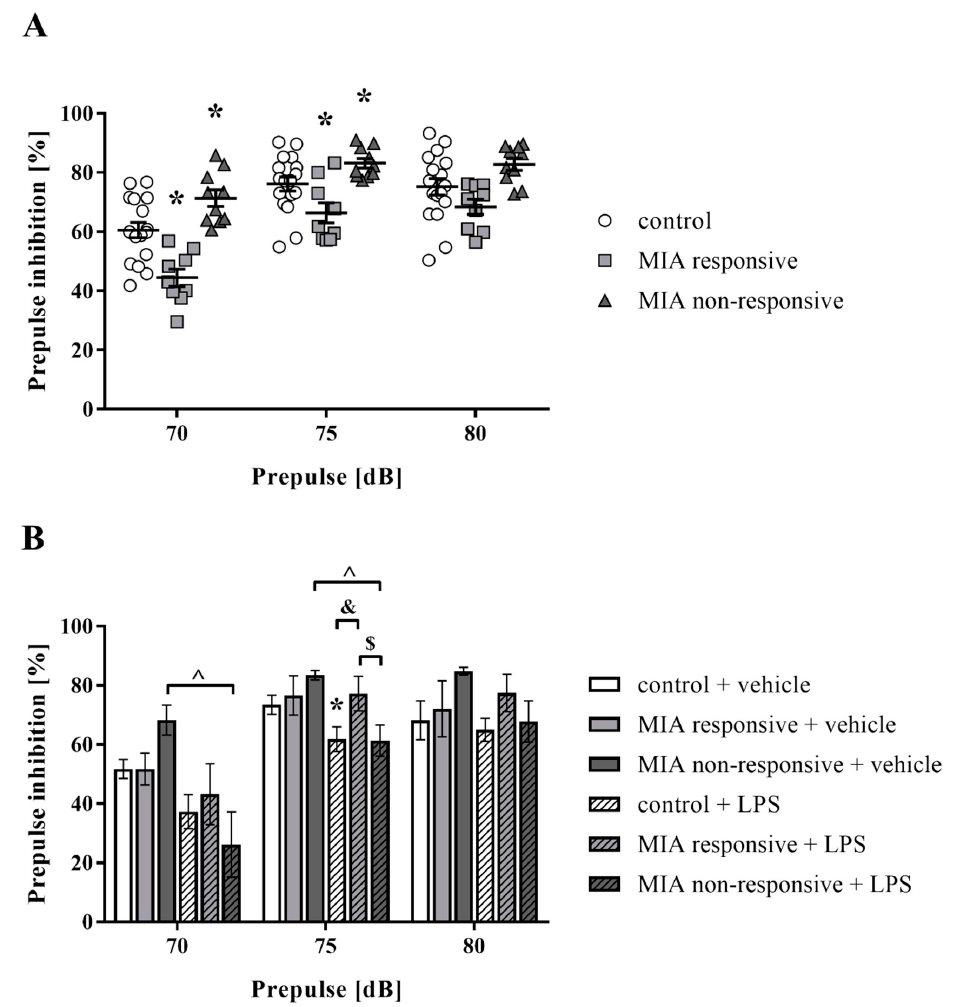
Figure 5. ( A ) The PPI test at PND100 revealed two distinct behavioural phenotypes: MIA responsive (with the deficit in PPI) and MIA non-responsive (without the deficit) in male Sprague-Dawley offspring exposed to MIA. n = 17 in the control group, n = 9 in the MIA responsive group, n = 10 in the MIA non-responsive group. * p < 0.05 vs. control group. The results are presented as the individual data points of the percentage of PPI (%PPI) induced by each prepulse intensity with the means ± SEM. Data were calculated based on the average startle amplitudes (AVGs). ( B ) At PND120, the animals were additionally subjected to the acute challenge with LPS and 2 h later, the PPI was evaluated again. n = 4–10. * p < 0.05 vs. control + vehicle, ^ p < 0.05 vs. MIA non-responsive + vehicle, $ p < 0.05 vs. MIA responsive + LPS, & p < 0.05 vs. control + LPS. The results are presented as the means of the percentage of PPI (%PPI) induced by each prepulse intensity ± SEM. Data were calculated based on the average startle amplitudes (AVGs).